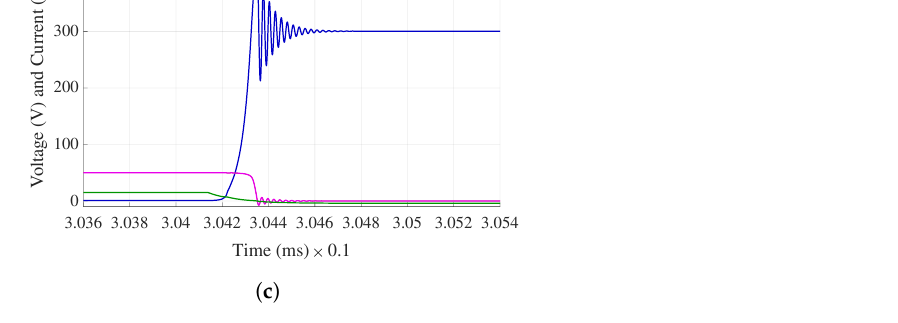
Figure 3. Simulation results, ( a ) applied waveform, ( b ) turn-on waveform, ( c ) turn-off